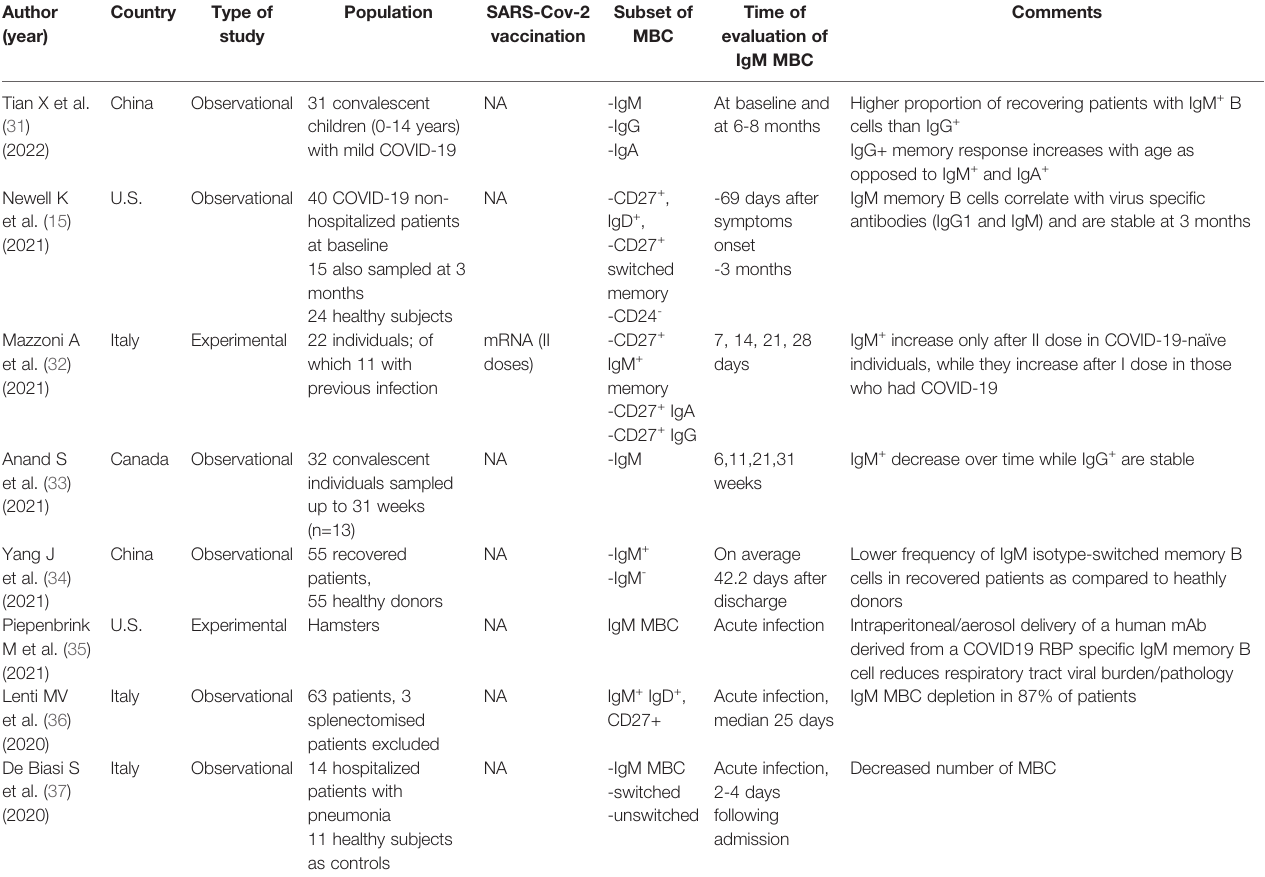
TABLE 1 | Studies primarily evaluating the role of IgM memory B cells in